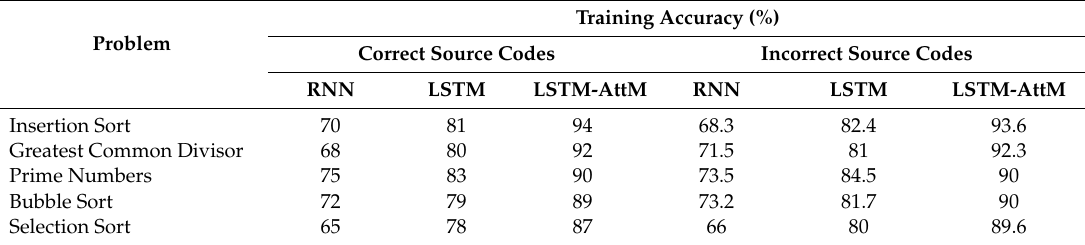
Table 2. Average training accuracy of models for various problem sets.